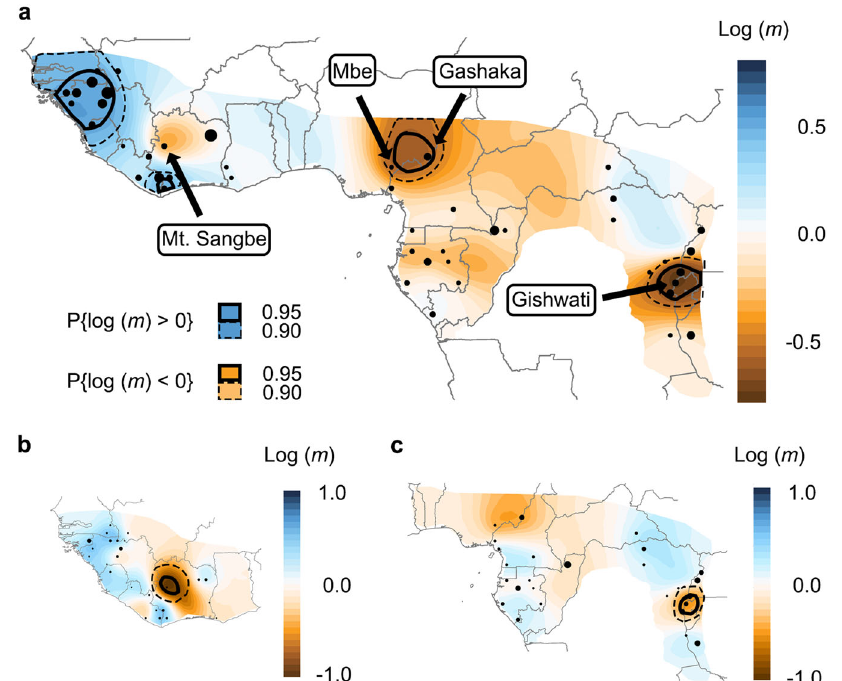
Fig. 3 Estimated effective migration surfaces (EEMS) at different population scales. a Map of EEMS for the entire species. Estimated effective migration rates ( m ) are mean centred on a log 10 scale. A value of 1 equates to a tenfold rate increase over population average, ranging from areas of low (brown) to high (blue) m . The intensity of the colours represents the relative difference from the population mean rates. Point diameter is proportional to the number of individuals sampled in a given deme (range = 1 – 72). Solid black lines indicate areas where the posterior probability of m differing from the mean rate is >95 percent and the dashed lines highlight areas that are >90 percent. These can be interpreted as signi fi cant effective ‘ barriers ’ to migration in brown areas and signi fi cant effective ‘ corridors ’ for migration in the blue areas. Two signi fi cant effective barriers were present: one corresponding to Gashaka and Mbe (Nigeria) and another originating from Gishwati (Rwanda) and shared with its nearest neighbours. These are localized areas of high differentiation, and when we excluded Mbe and Gishwati from the dataset, these barriers were no longer signi fi cant (Extended Data Fig. 6a, c). Notably, historical effective barriers separating the subspecies ’ ranges were not detected. Effective migration rates within much of Pan troglodytes verus were signi fi cantly higher than average. b Historical EEMS map of P. t. verus . There was a signi fi cant barrier associated with Mt. Sangbé in Côte d ’ Ivoire. When we removed Mt. Sangbé the barrier was no longer signi fi cant, but it was still present, suggesting the possibility of reduced historical gene fl ow across Côte d ’ Ivoire. c Historical EEMS (Extended data Fig. 6c). Rates of m between the panels are relative and not directly